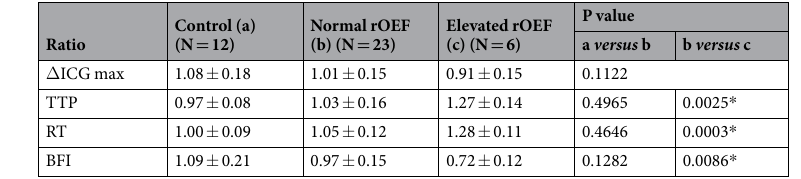
Table 3. rOEF and measured values of parameters by NIRS/ICG. Ratio is given as affected side to non- affected side ratio. Values are given as mean ± standard deviation. * A P value < 0.05 was defined as statistically significant. BFI, blood flow index; ICG, indocyanine green; NIRS, near-infrared spectroscopy; rOEF, regional oxygen extraction fraction; RT, rise time; TTP, time to